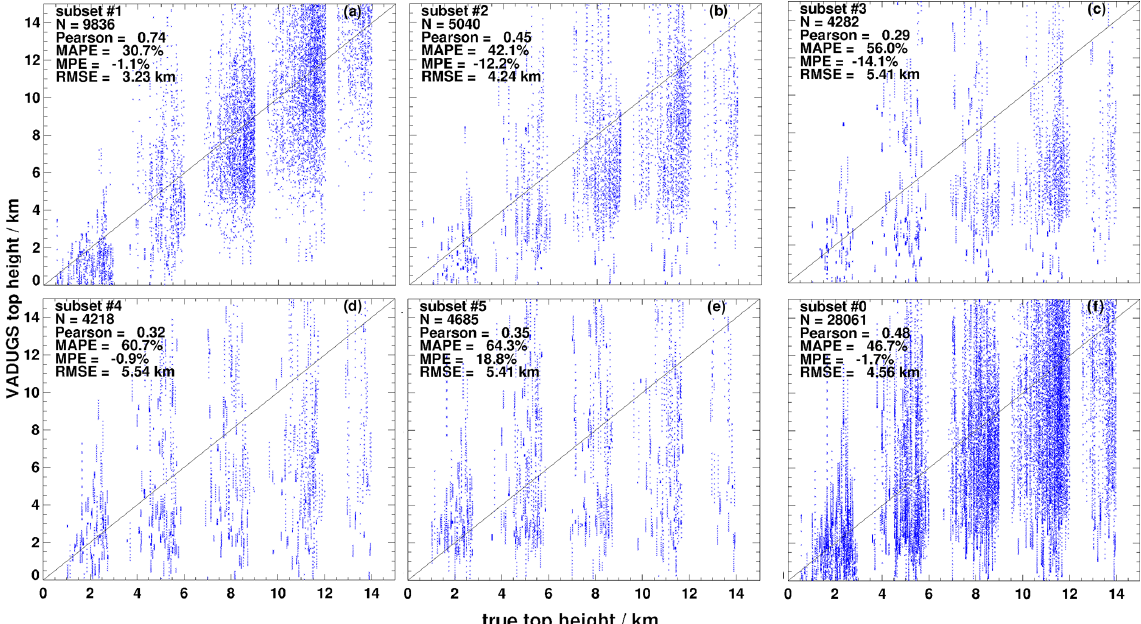
Figure 8. (a) – (f) True against retrieved cloud top height for the reduced simulated validation data set as a function of satellite viewing angle (subsets #1–#5). The solid black line shows the identity; for each data set the corresponding number of samples (N), the Pearson correlation coefficient, the root mean squared error (RMSE), the mean absolute percentage error (MAPE) and the mean percentage error (MPE) are